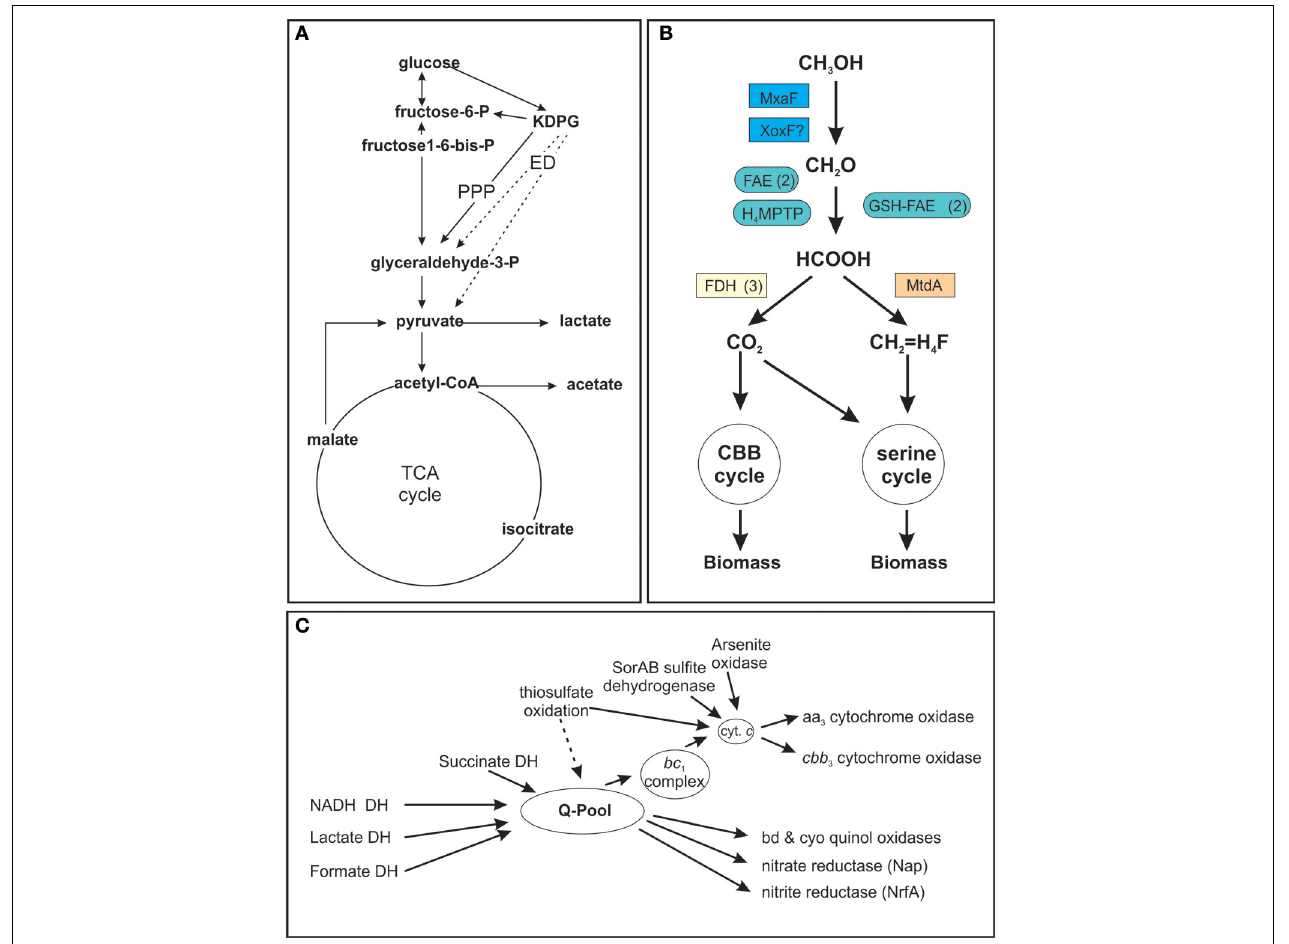
FIGURE 1 | Schematic representation of S. novella metabolic pathways. (A) Glucose catabolism and TCA cycle (B) Methanol degradation (C) Respiratory chain components. (A) Dashed arrows denote reactions of the Entner Doudoroff (ED) pathway, PPP, Pentose Phosphate Pathway; DH,